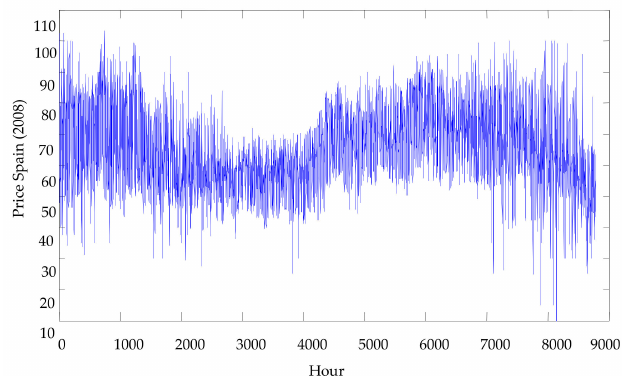
Figure 9. Electricity price changes per hour in 2008 in Spain.